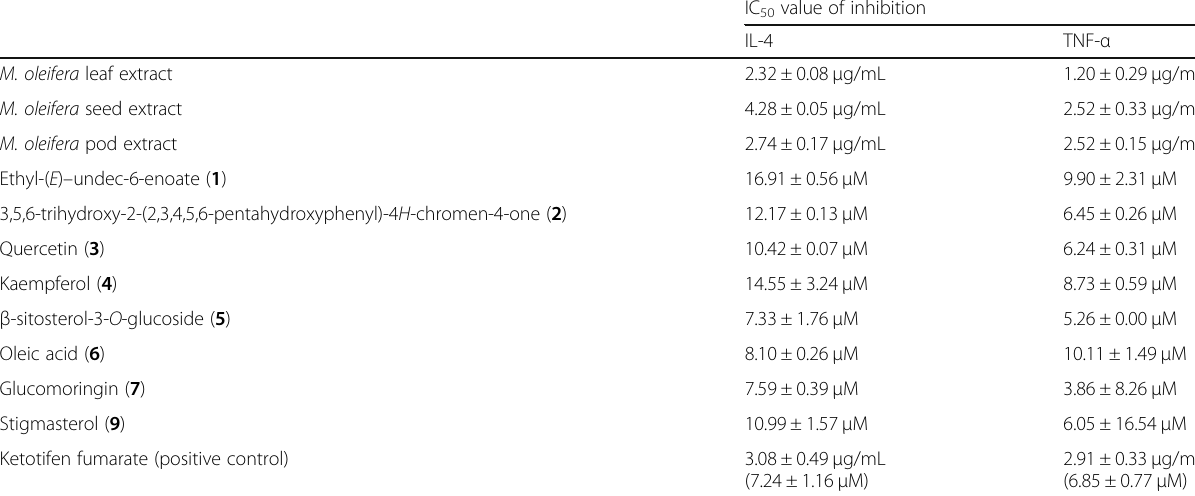
Table 5 IC 50 value of inhibition towards IL-4 and TNF- α